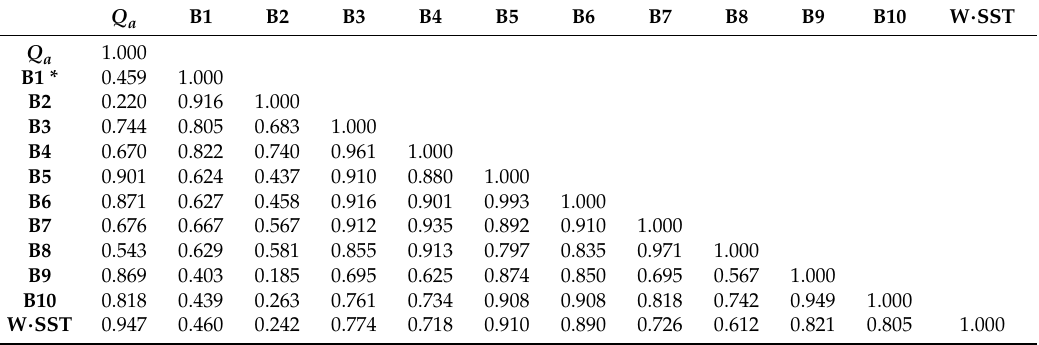
Table A1. Values of Pearson’s correlation coefficient for the parameters in Equation (2).